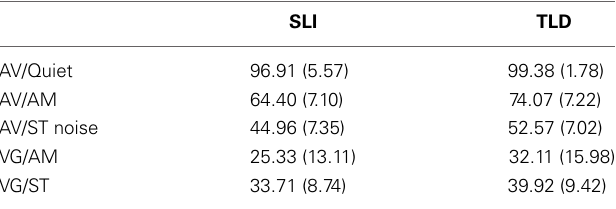
Table 8 | Mean percent correct responses for AV in quiet, AM noise and ST noise, and mean value for Visual Gains